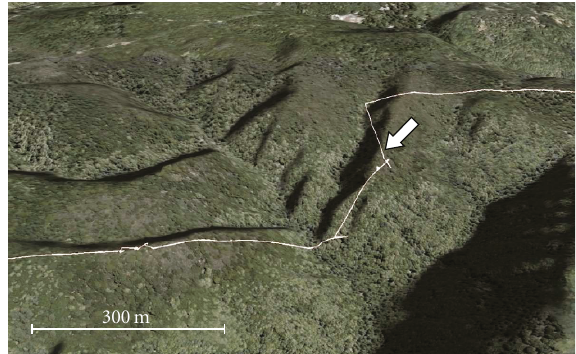
Figure 19: Subset of mountain lion GPS data. This data was collected on October 17, 2008 from a CSN on a mountain lion in the Santa Cruz Mountains, CA, USA. Arrow indicates an event with periodic accelerometer data. See Figure